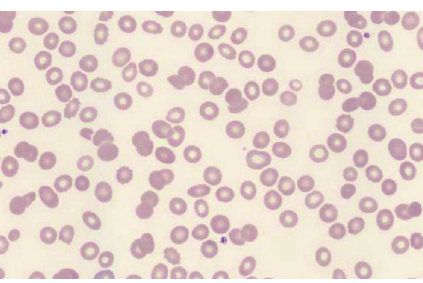
Figure 2: Peripheral blood smear showing normochromic RBCs with anisocytosis/poikilocytosis, thrombocytopenia, and paucity of PMNs and